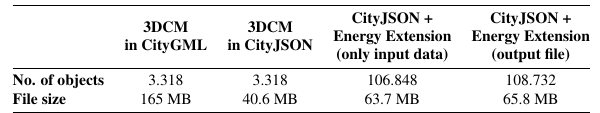
Table 1. File size and the number of objects stored in each input/output file